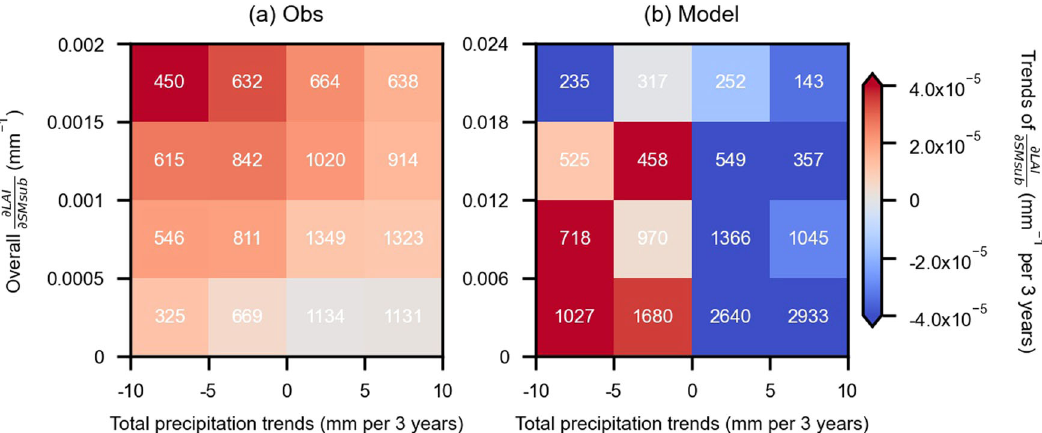
Fig. 4 Trends of LAI sensitivity to sub-surface soil moisture ð Trendsof ∂ LAI ∂ SMsub Þ grouped by precipitation trends and overall sensitivity ð Overall ∂ LAI ∂ SMsub Þ . a Colors indicate median values of trends in LAI sensitivity to sub-surface soil moisture in observational ensemble means (Obs) grouped by precipitation trends and overall sensitivity; numbers of grid cells in each group are shown in white. b Similar as in a but for ensemble means of land surface models